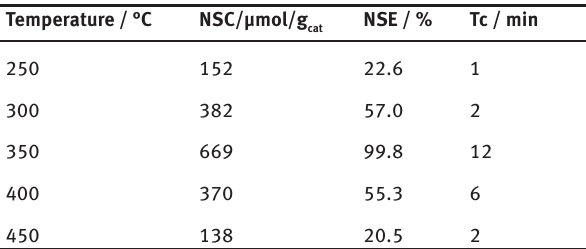
storage capacity, NO Table1: NO X time at different